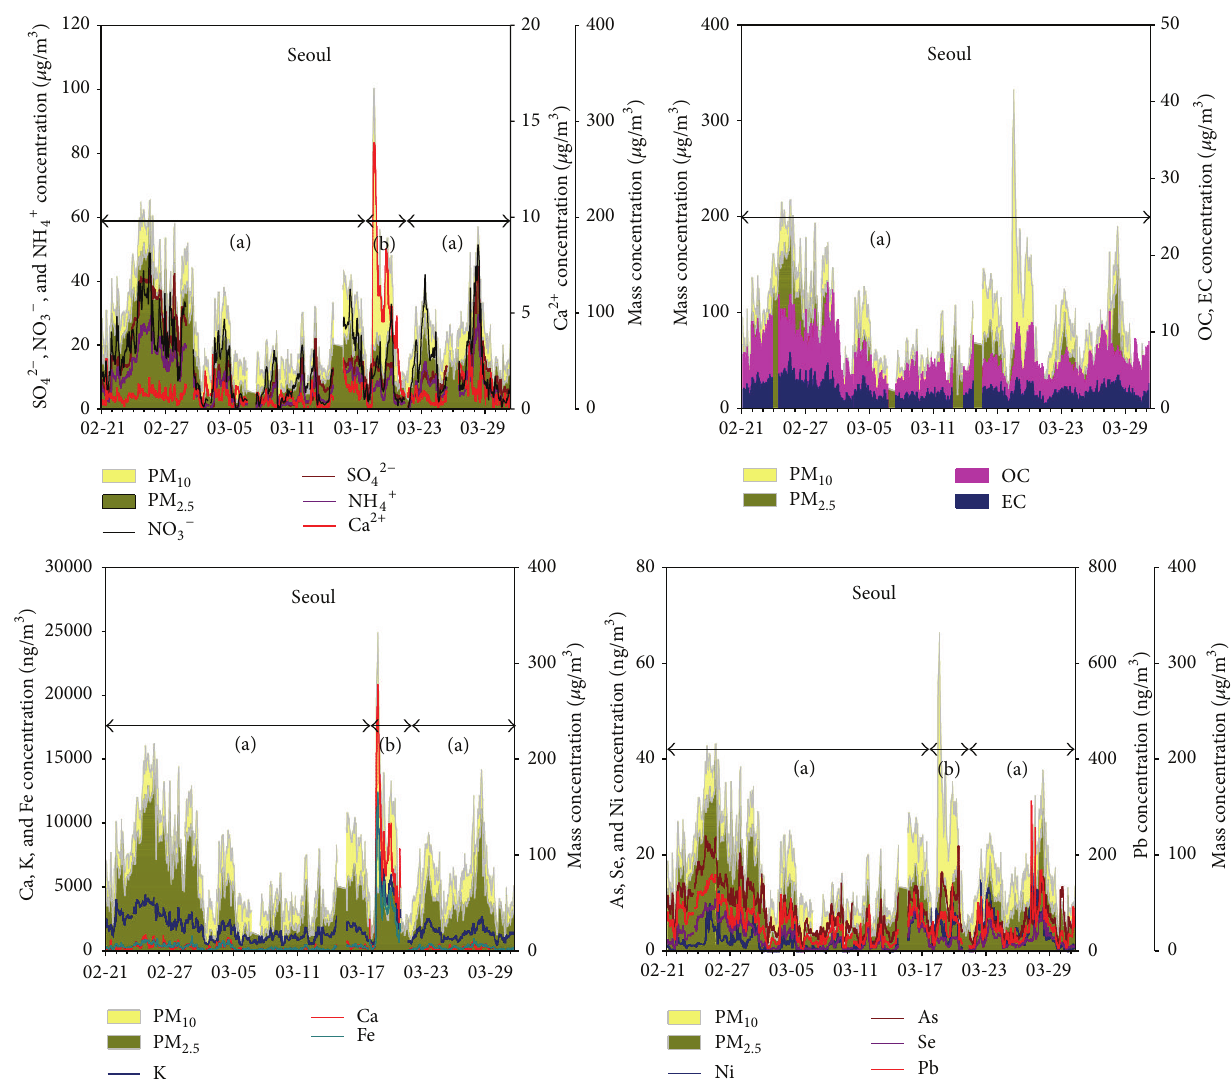
Figure 2: The time series of individual chemical components of episodic periods bounded: (a) PM 2.5 and (b) PM 10